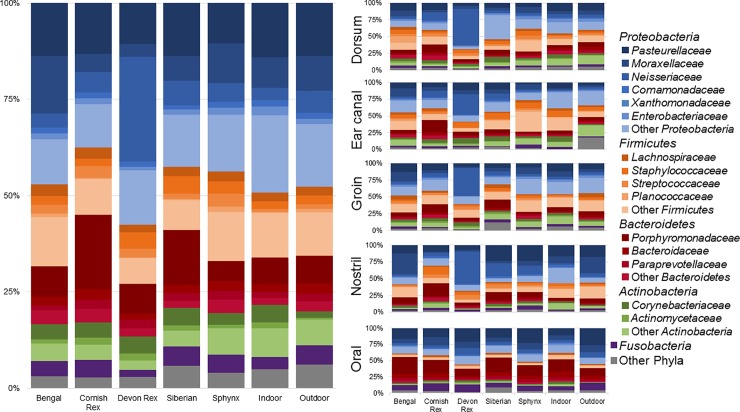
Average relative abundance of bacterial taxa.The average relative abundance of bacterial taxa across the different cat breeds and outdoor cats including all body sites and separated by body site.